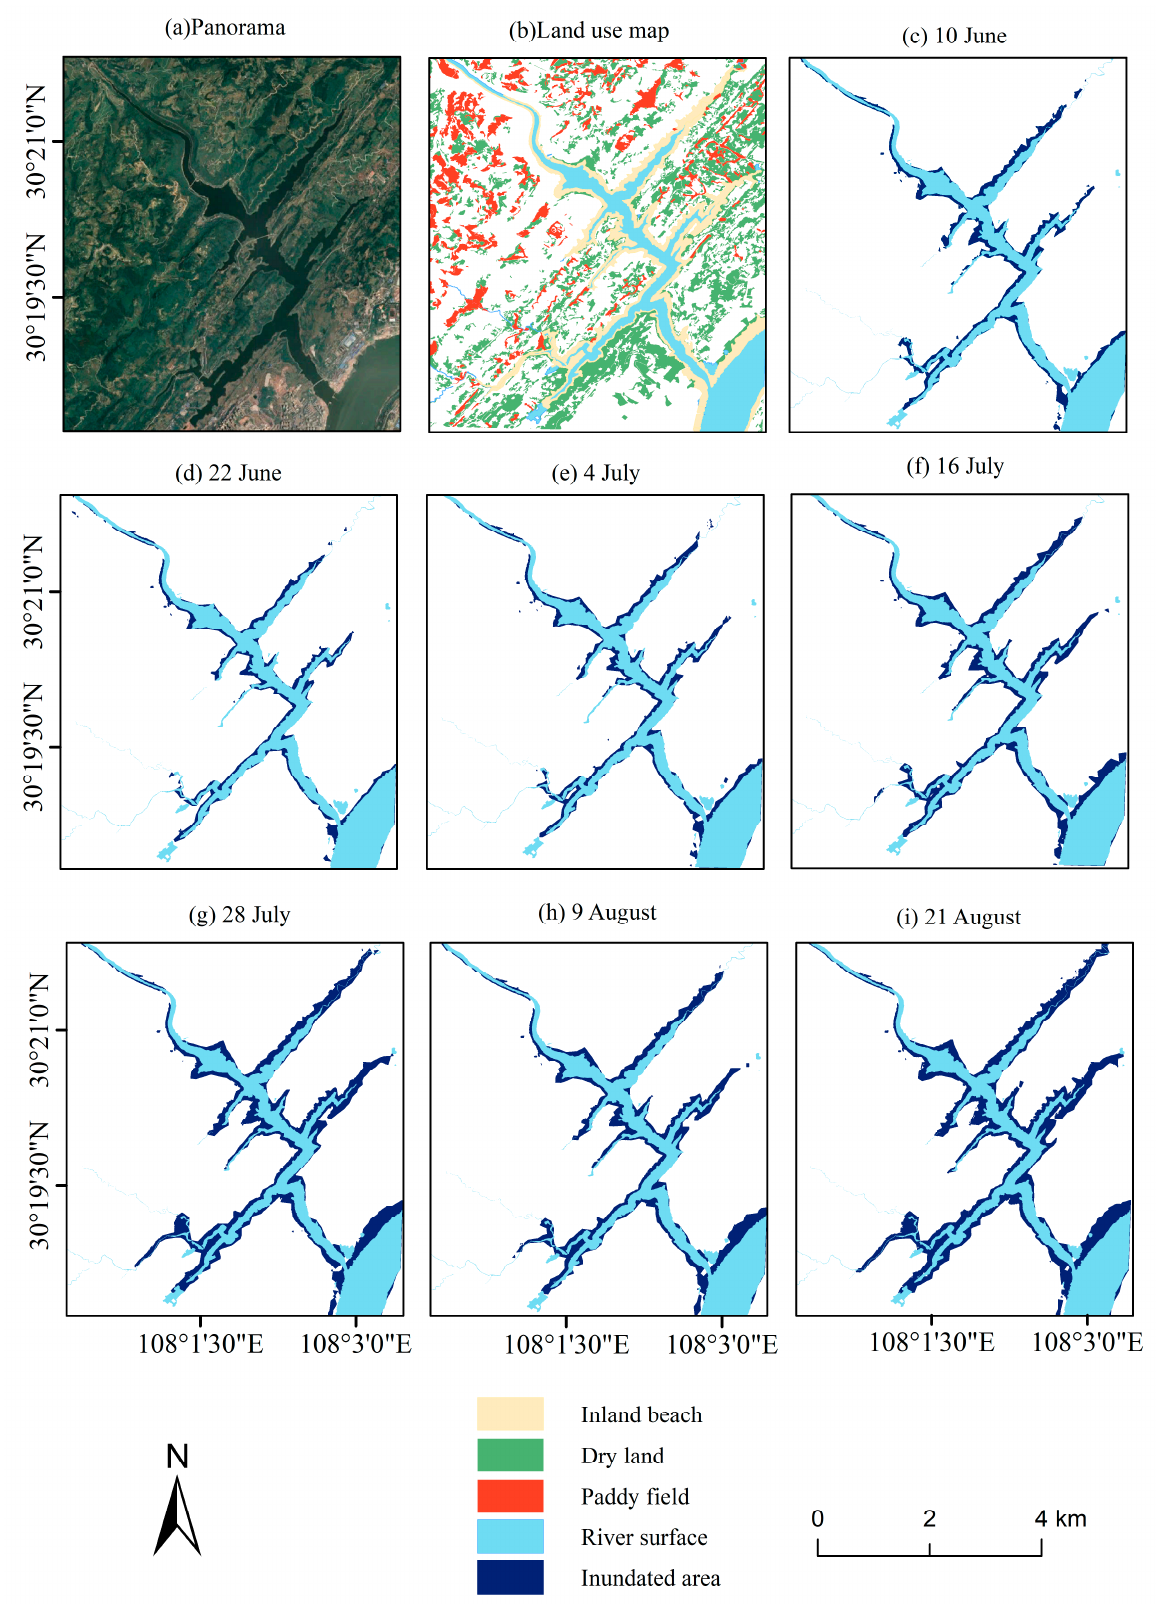
Figure 9. Flood inundation maps of Huangjin River during different periods: ( a ) panorama of Huangjin River, ( b ) land use of Huangjin River Region, ( c ) 10 June, ( d ) 22 June, ( e ) 4 July. ( f ) 16 July, ( g ) 28 July, ( h ) 9 August, and ( i ) 21 August